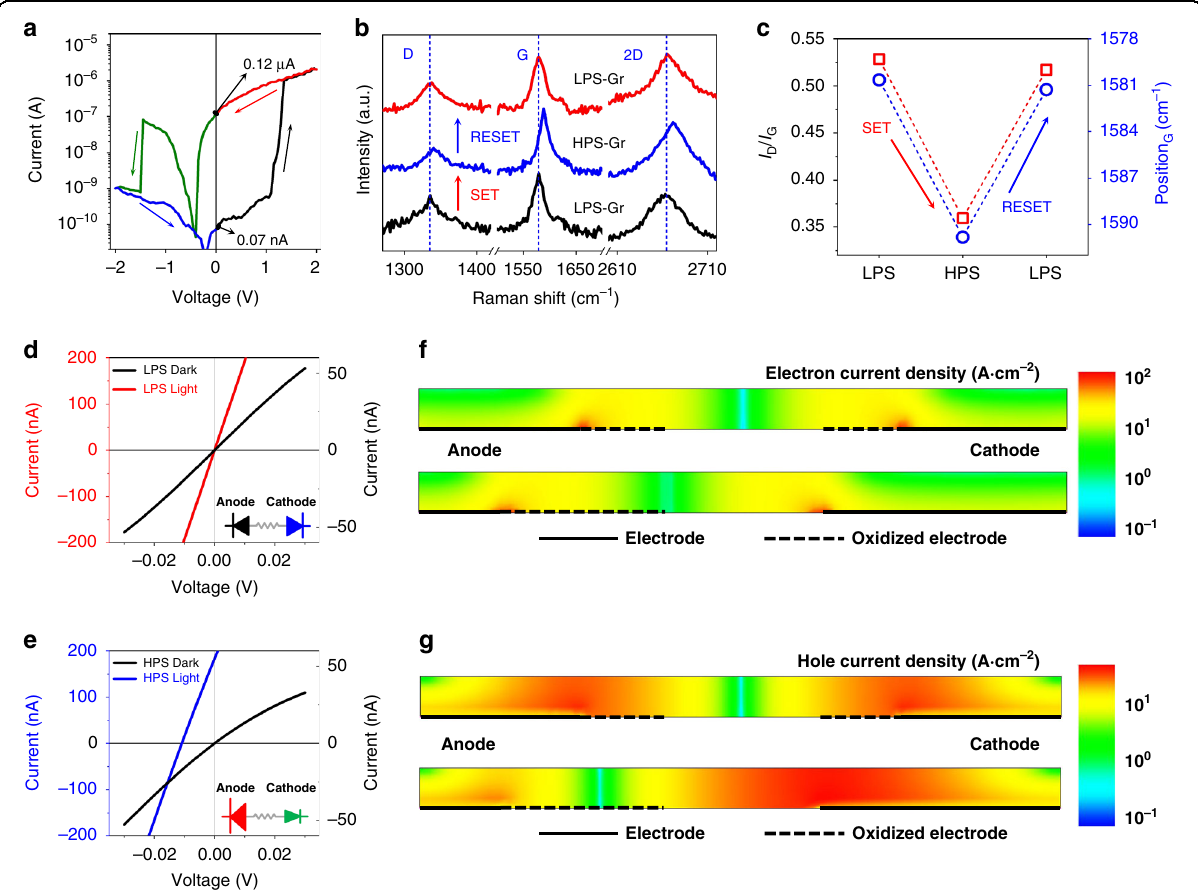
Fig. 2 Photoresponse switching mechanism. a I-V characteristics of a G/M/G device with binary photoresponse switching when the voltage sweeps from 0 to 2 V, from 2 V to – 2 V, and back to 0 V. b Raman curves showing the evolution of redox reactions on graphene electrodes when switching between HPS and LPS. c Correlation of changes in the ratio of the intensities of Raman scattering and shifts of the G mode of graphene electrodes and states of the non-volatile photoresponse. TCAD-simulated dark/photo current of the G/M/G device for LPS ( d ) and HPS ( e ). The insets of ( d ) and ( e ) demonstrate the qualitative device model for LPS and HPS, respectively. f The electron current density distribution of LPS (top) and HPS (bottom) under illumination, simulated with TCAD. g TCAD simulated the hole current density distribution of LPS (top) and HPS (bottom) under illumination, simulated with